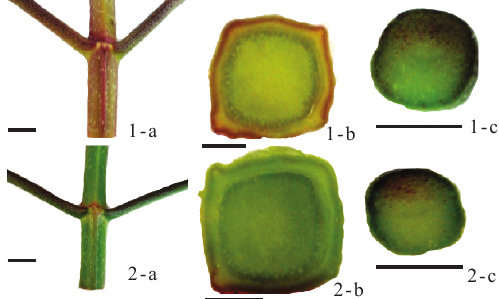
Fig. 3 - Sections of stems (1-a, b) and petioles (1-c) of Kalanchoe pinnata seedlings under full sunlight and 25% of light (stem: 2-a, b; petiole: 2-c). Bars = 10mm (1-a, 2-a); 5mm (1-b,c; 2-b,c).